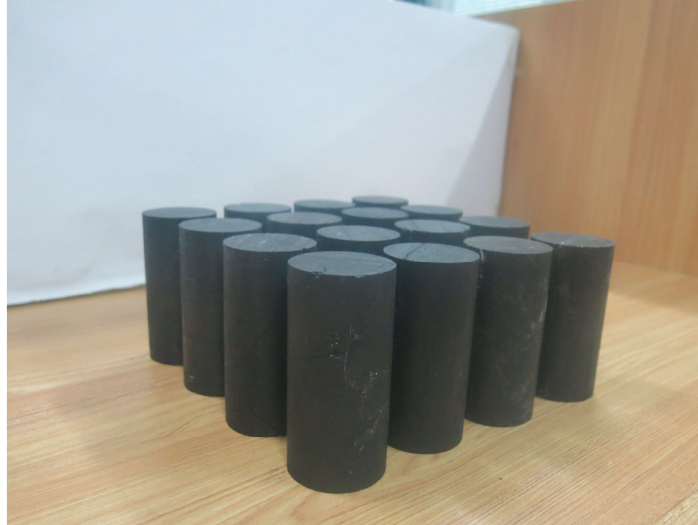
Figure 2. Experimental coal pillar specimens.